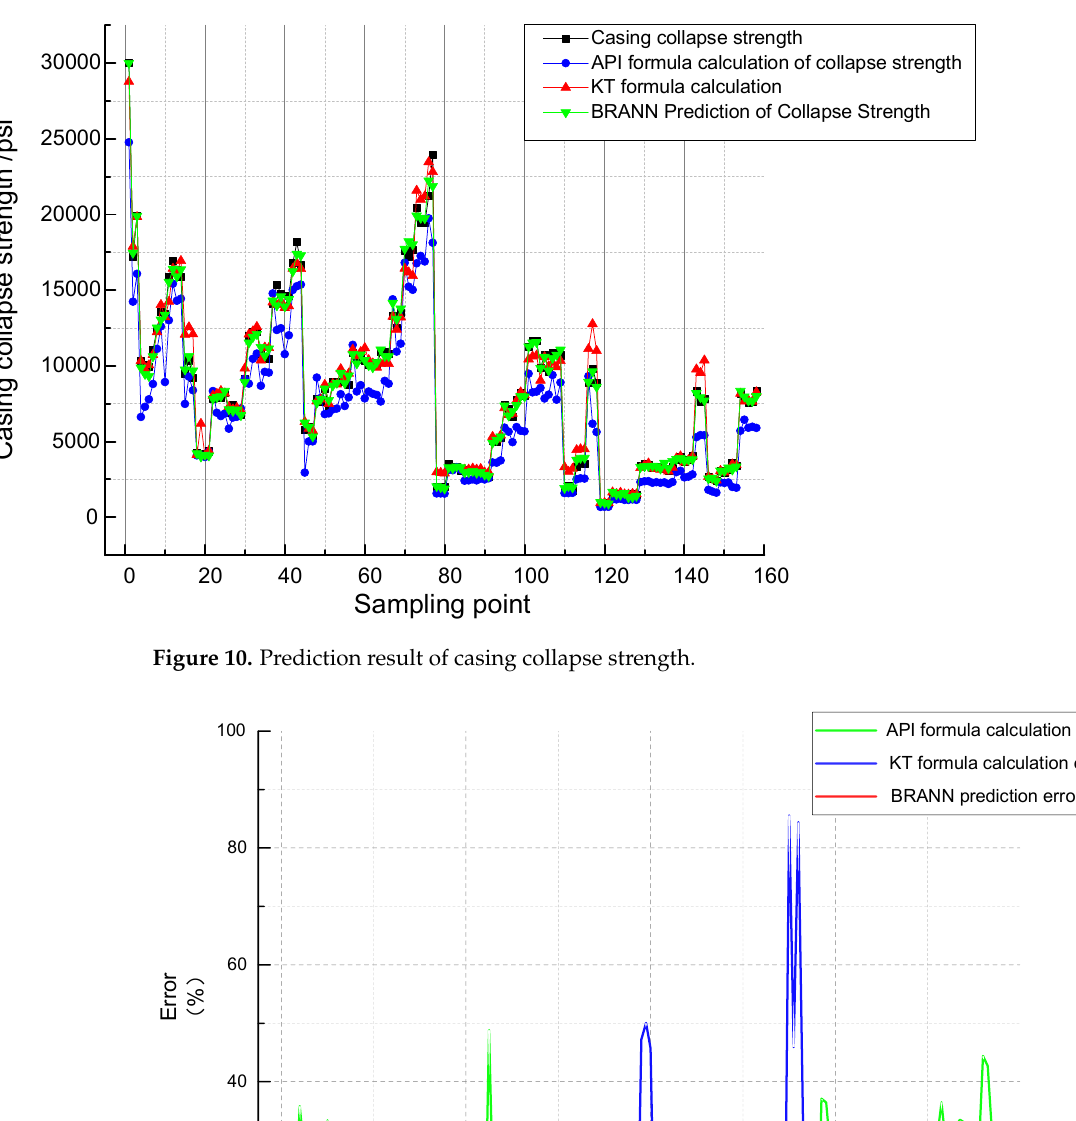
Table 5. Output error of blind test samples.